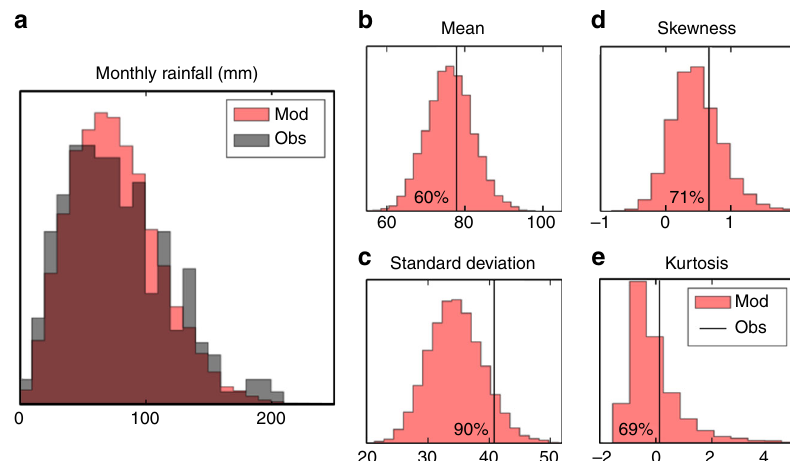
Fig. 2 Model and observed rainfall totals are indistinguishable. a The distribution of October to March monthly rainfall totals (in mm) of observations from the Met Of fi ce NCIC data set, 1981 to 2015, and the model simulations for south east England. b – e The distributions of proxy south east England model time series mean, standard deviation, skewness and kurtosis compared to the observed values indicated by the black vertical line